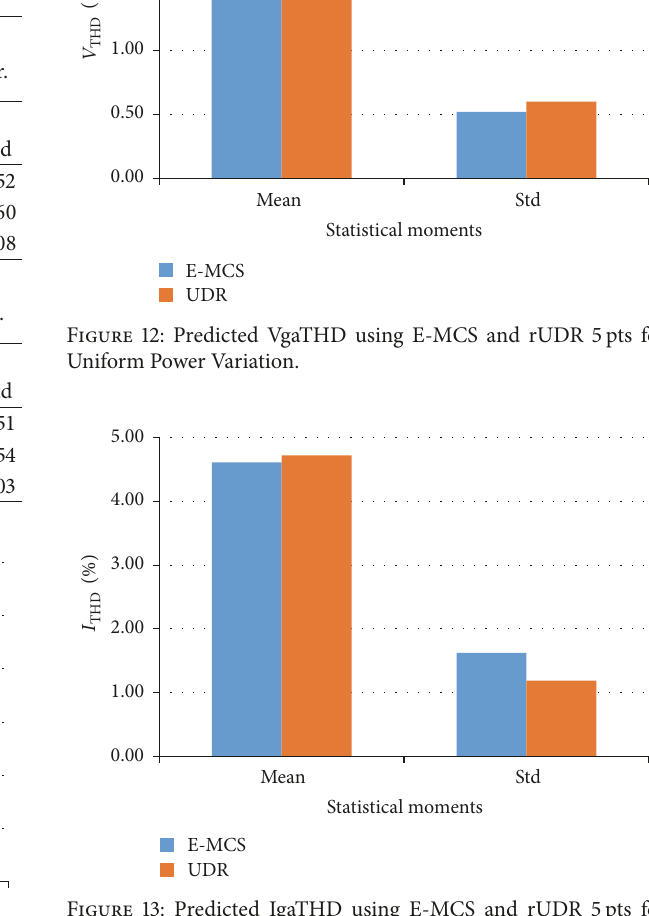
Figure 13: Predicted IgaTHD using E-MCS and rUDR 5 pts for Gaussian Power Variation.